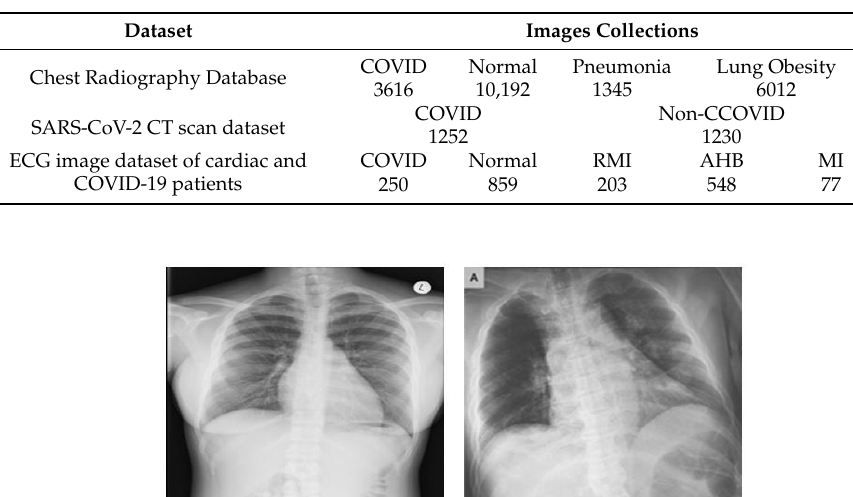
ECG trace images. Figure 5 shows a COVID-19 sample ECG image of the dataset. Table 2. Datasets details.